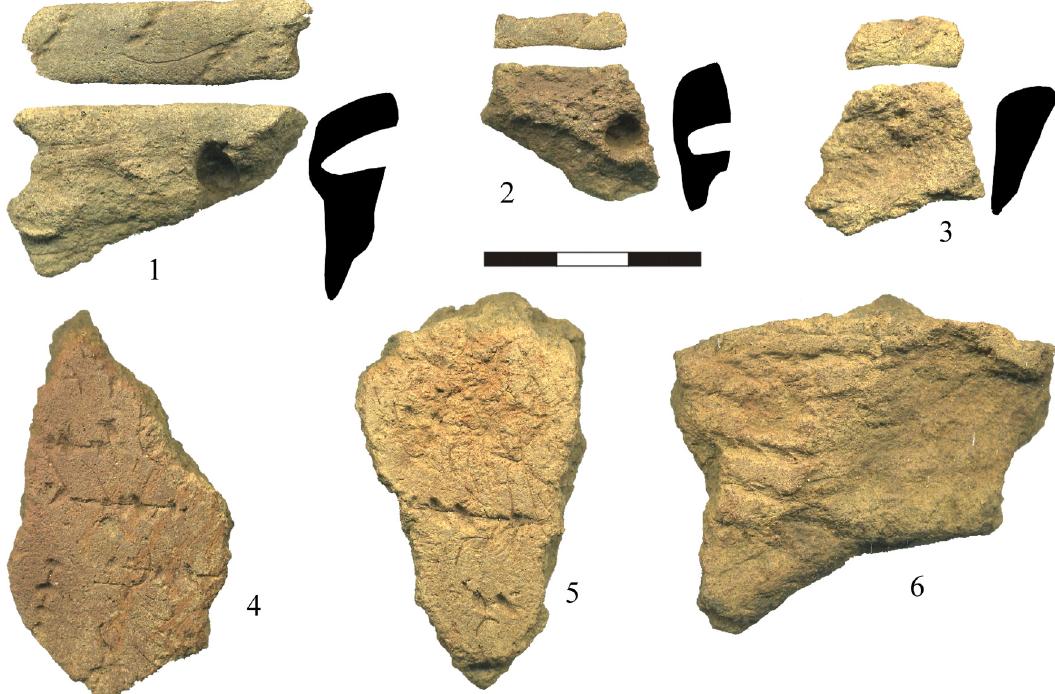
Figure 6: ( 1 – 6 ) Corded Ware, Estonian variant ( Rosson 9; MAE RAS )